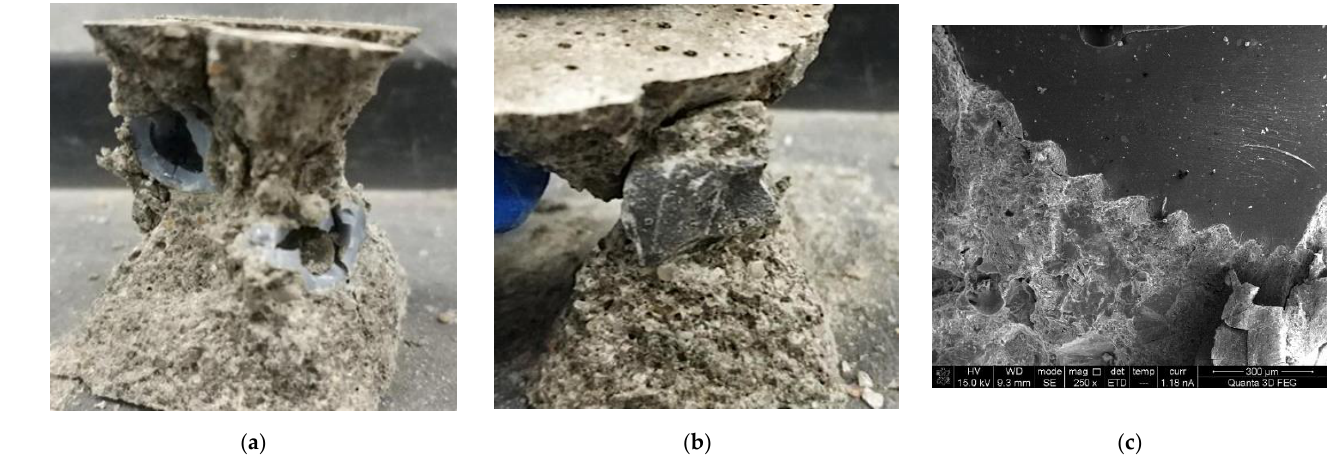
Figure 8. Damage condition of the cementitious composite samples. ( a ) Cementitious composite mixed with 3D − printed aggregate. ( b ) Cementitious composite mixed with basalt aggregate. ( c ) The interface between the phase change aggregate and the mortar matrix.